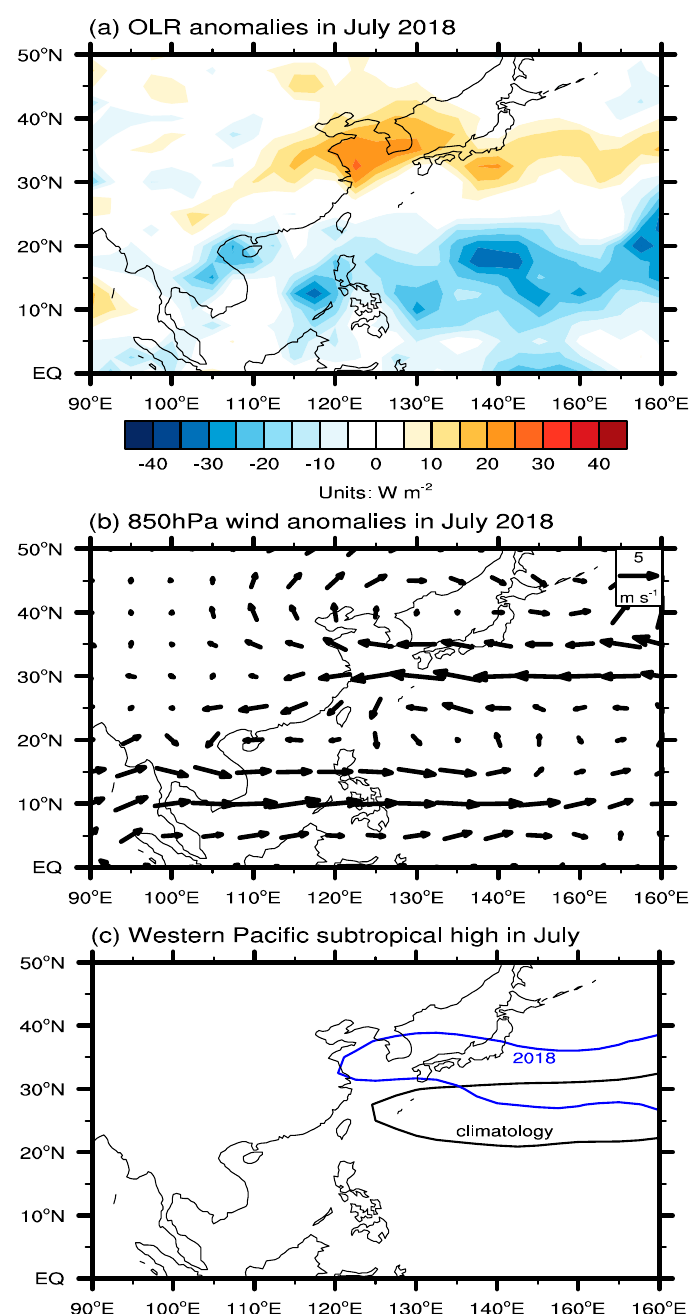
Figure 2. The anomalies of ( a ) outgoing longwave radiation (OLR; SI = 5 W m − 2 ) and ( b ) 850 hPa winds in July 2018 (unit: m s − 1 ); ( c ) the location of the western Pacific subtropical high (indicated by the 5880 gpm counter) in July for the climatology (black) and the year 2018 (blue).